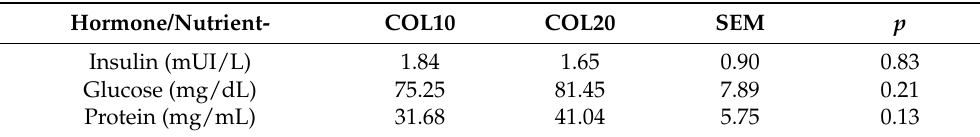
Table 2. Insulin, glucose and protein plasma concentration in neonatal piglets fed 20% (COL20, n = 8) or 10% (COL10, n = 8) of birth weight of colostrum over the first 24 h after birth. Hormone/Nutrient- COL10